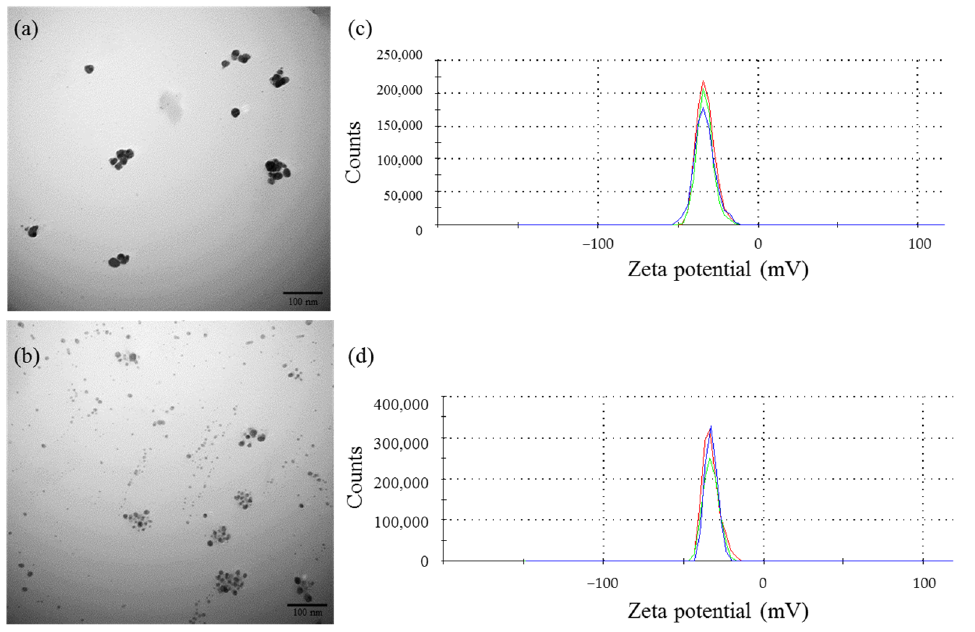
Figure 2. TEM images ( a ) A-BG-AgNPs and ( b ) E-BG-AgNPs. Zeta potential values ( n = 3) of ( c ) A-BG-AgNPs and ( d ) E-BG-AgNPs.